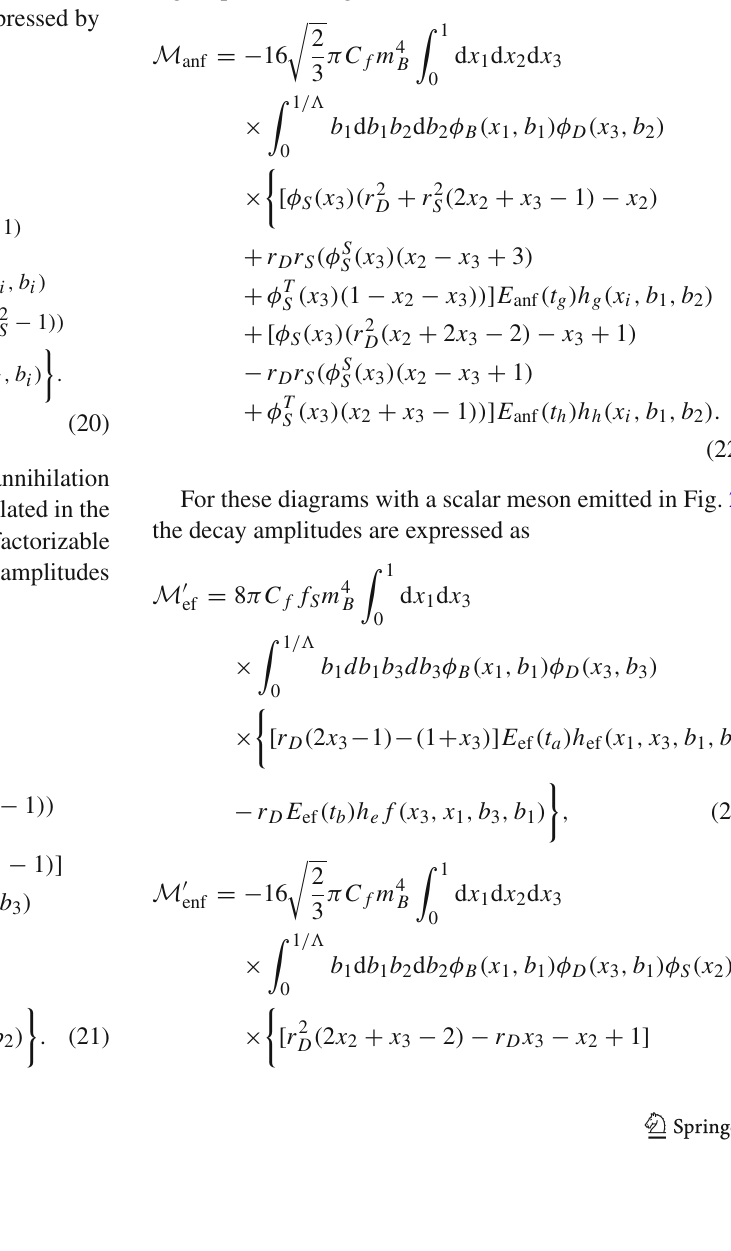
Fig. 1 Leading order Feynman diagrams contributing to the B → D